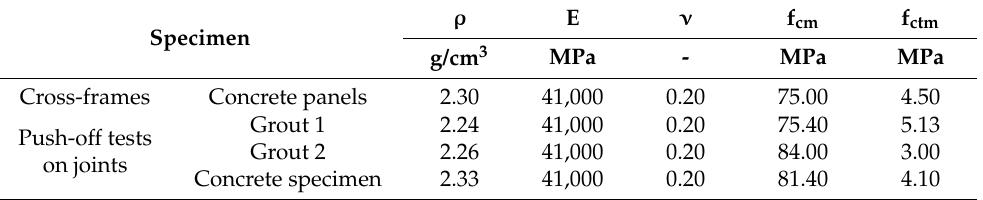
Table 3. Abaqus material parameters for concrete for tests on cross frames and push-off joints.